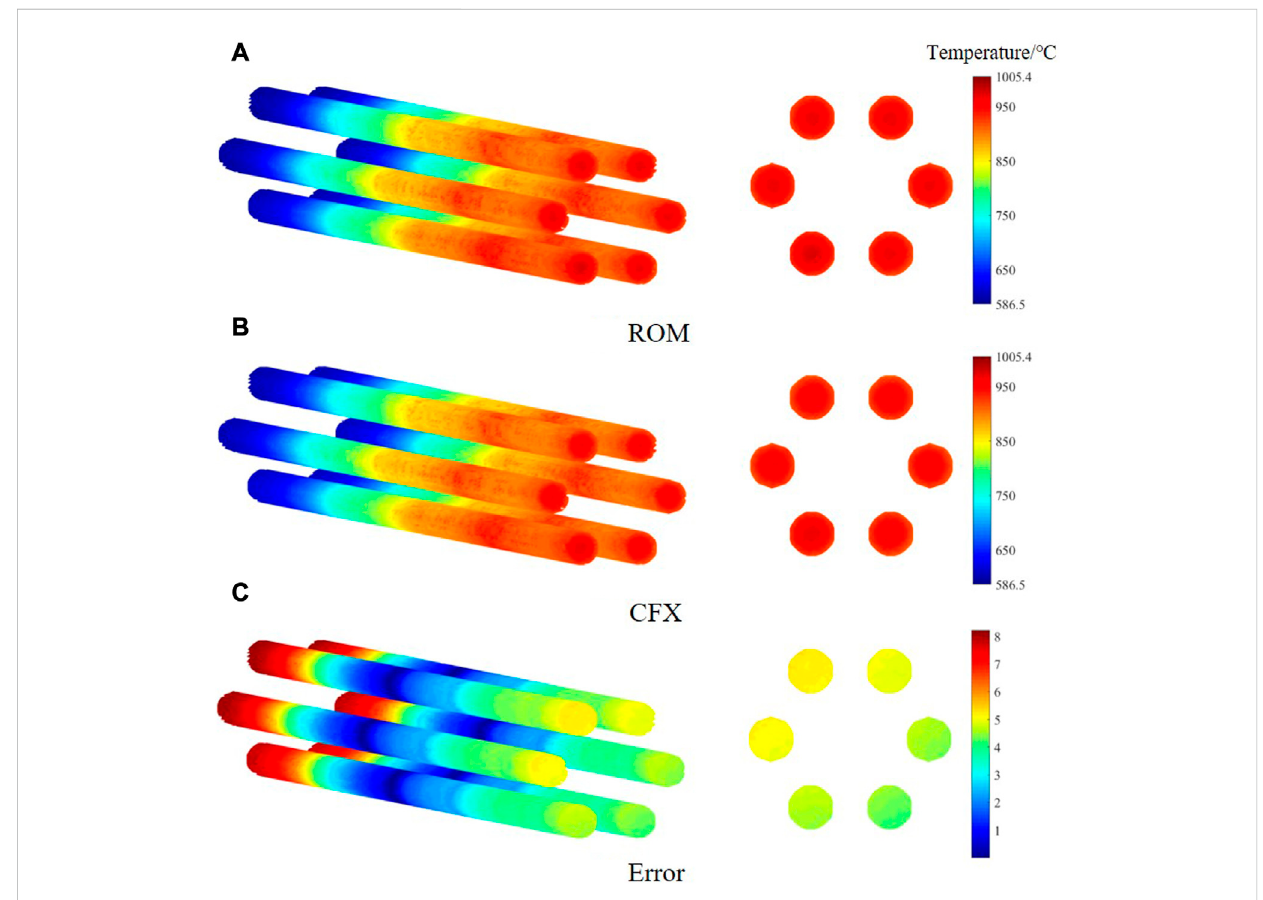
FIGURE 9 Temperature contour comparison for fuel rods zone. (A) ROM. (B) CFX. (C) Error.